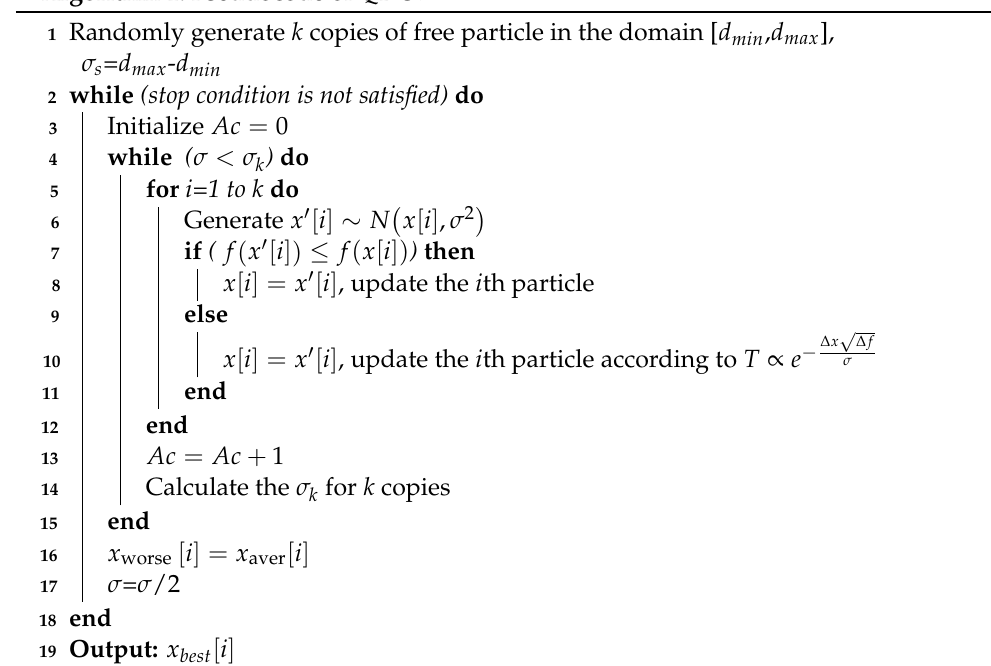
Algorithm 1: Pseudocode of